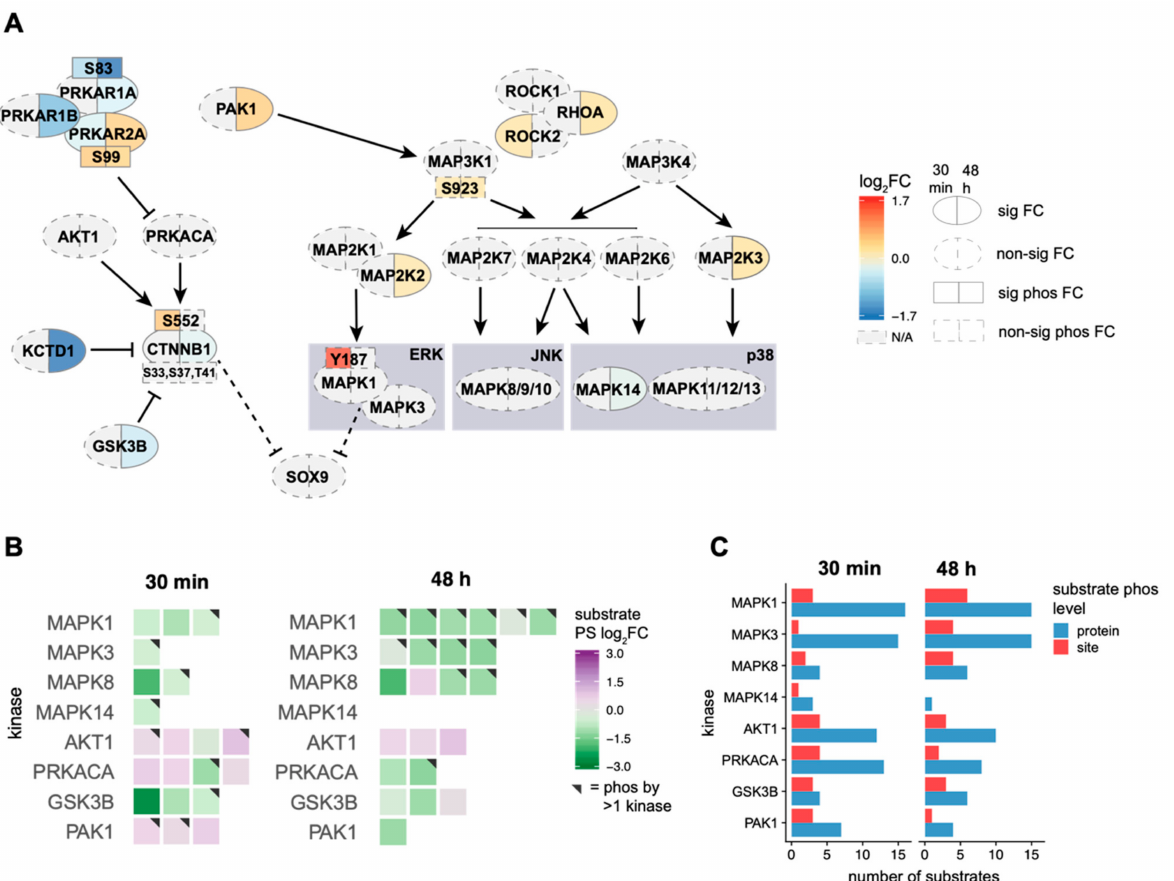
Figure 6. Proteins involved in MAP3K1/MAP3K4 cascades in response to oestrogen and analysis of the activity of key kinases. ( A ) Fold changes to MAP3K4 and MAP3K1 pathways and related proteins following EE2 treatment for 30 min (left half of oval) and 48 h (right half of oval). Significant ( p < 0.05) fold changes (FC) for proteins (oval) and phosphoproteins (rectangle) are surrounded with a solid line, while non-significant ( p > 0.05) changes are surrounded with a dashed line. Indirect relationships are indicated by a dashed line. Proteins with no detected significant change are indicated by a grey fill (N/A). EE2 treatment led to upregulation of proteins involved in the MAP3K1 cascade ( B ) Target substrate phosphosite (PS) log 2 FCs for key kinases involved in the MAP3K1/MAP3K4 cascades after 30 min and 48 h of EE2 treatment. Grey triangles in the top right corners of the tiles indicate this substrate phosphosite is phosphorylated by more than one kinase. A decrease in phosphorylation indicates reduced activity of the corresponding kinase. ( C ) Number of substrates with a significant change on either the phosphosite (red) or protein (blue) level for each of the key kinases in the MAP3K1/MAP3K4 cascades following EE2 treatment for 30 min or 48 h. Protein level phosphorylation indicates that the target protein had a change in phosphorylation, but not at the precise phosphosite recorded as being a target of that kinase. A large differential between the number of protein and site level changes may indicate a larger change in kinase activity than was shown in ( B